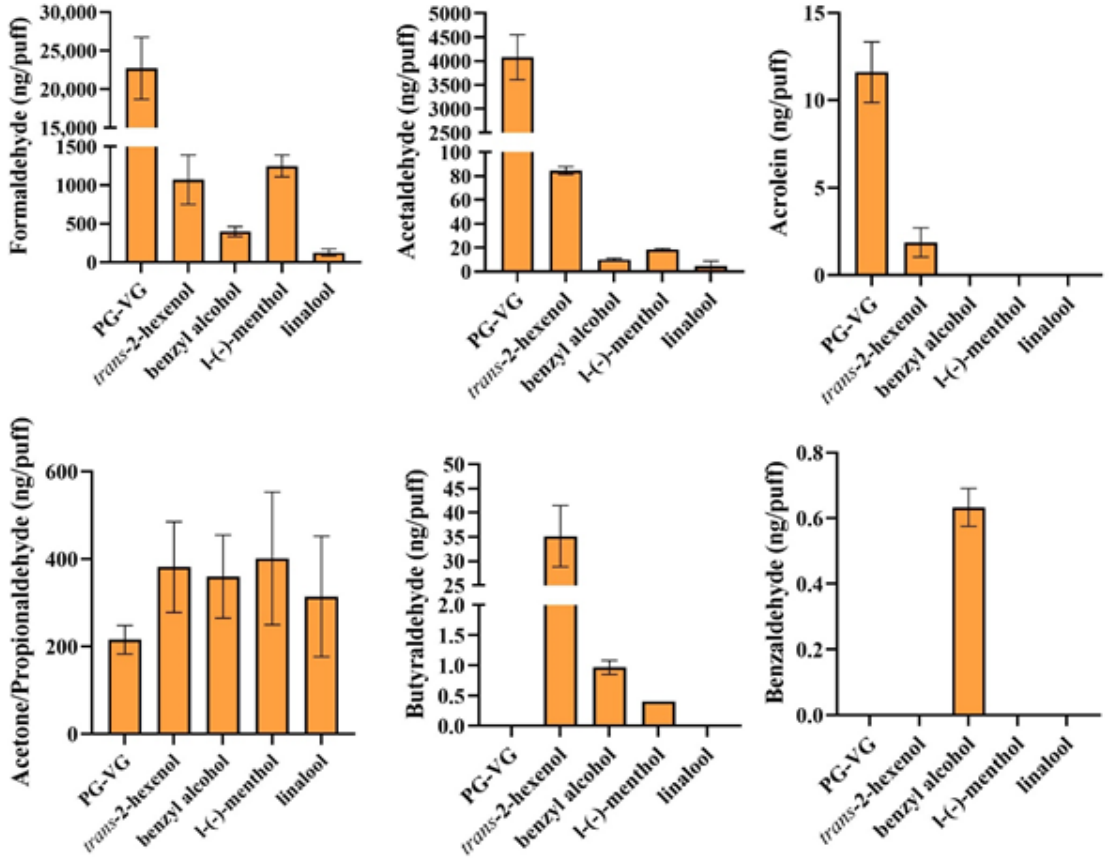
Figure 2. Levels of target carbonyls per puff (ng/puff) in PG-VG and flavored e-liquids ( trans -2-hexenol, benzyl alcohol, l-(-)-menthol, and linalool). Target carbonyls measured are formaldehyde, acetaldehyde, acrolein, acetone/propionaldehyde, butyraldehyde, and benzaldehyde. Error bars represent one standard deviation of triplicate measurements.